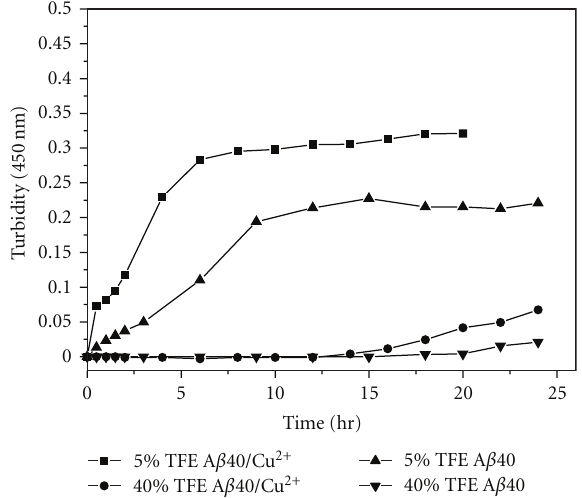
Figure 2: The aggregation process of A β 40 and A β 40/Cu 2+ complex in 5% and 40% TFE measured by turbidity assay. ( ) A β 40 in 5% TFE, ( • ) A β 40/Cu 2+ in 40% TFE, and ( 5% TFE, ( (cid:2) A β 40 in 40% TFE.